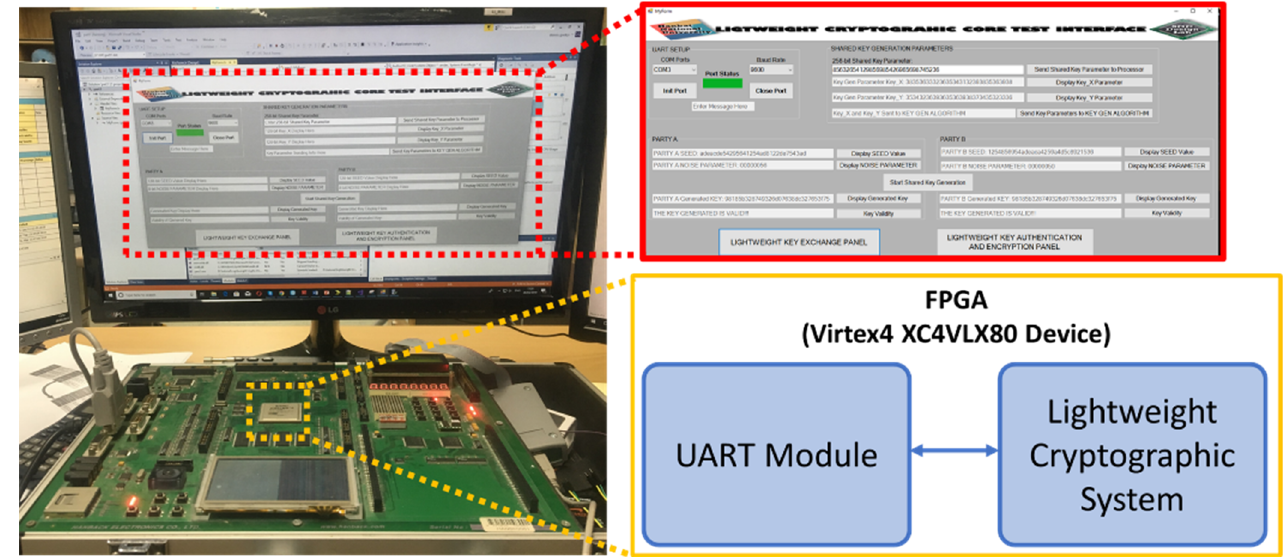
Figure 21. FPGA board setup for verifying the proposed lightweight cryptographic SoC.